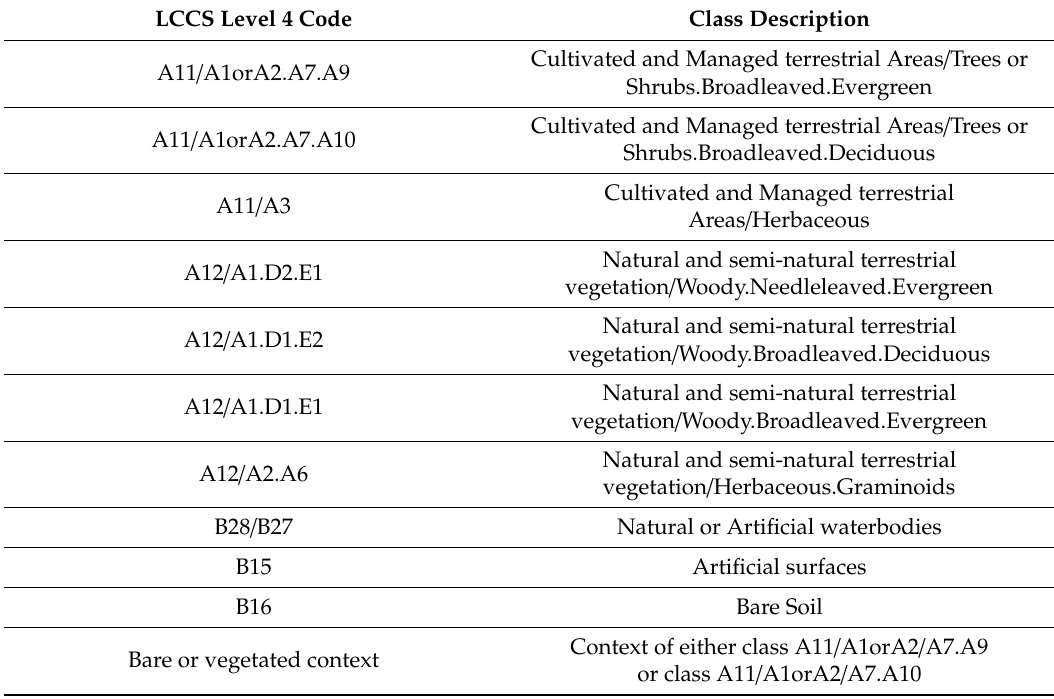
Table 3. List of small-object (SO) land cover (LC) classes in LCCS taxonomy in Murgia Alta